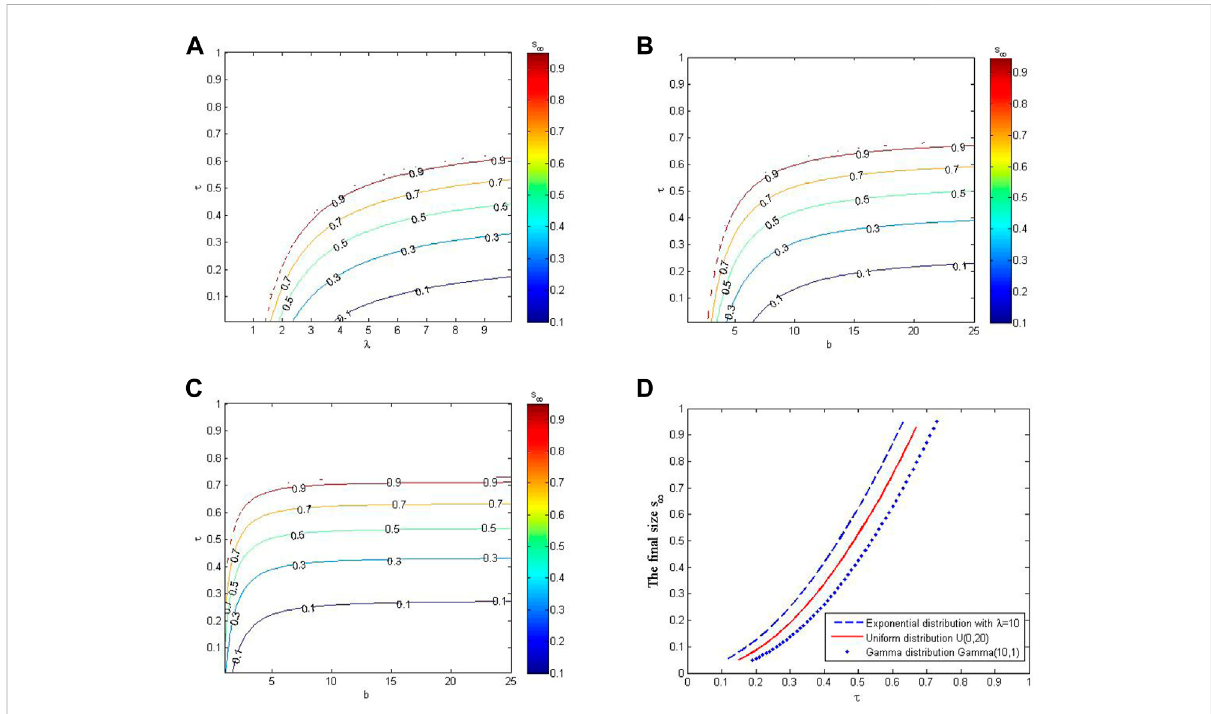
FIGURE 3 Effects of different contact tracing rates and awareness distributions on the fi nal epidemic size, s ∞ . (A – C) Contours of s ∞ as the function of contact tracing rates and distribution parameters. (D) The trend of s ∞ as the function of tracing rate when the awareness processes have different distributions but the same mean. Here, the variances of E (10), U (0, 20), and Gamma (10, 1) are 100, 100/3, and 10,